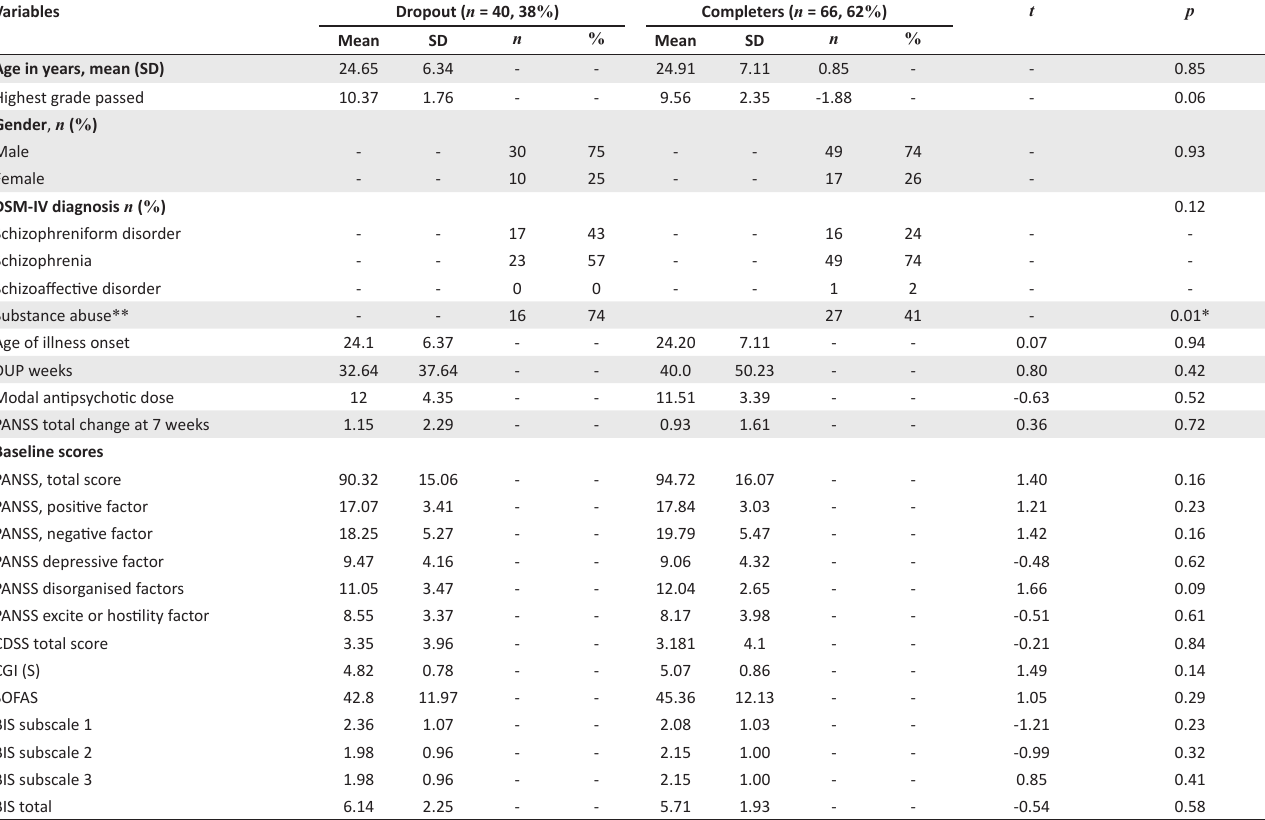
DSM-IV, Diagnostic and Statistical Manual of Mental Diseases, Fourth Edition; s.d., standard deviation; PANSS, positive and negative syndrome scale; SOFAS, social and occupational functioning assessment scale; CDSS, Calgary depression scale for schizophrenia; BIS, Birchwood insight scale, CGI, clinical global impression scale; p , significance value; T -test, for continuous variables; DUP, duration of untreated psychosis. * , Statistical significance at p <